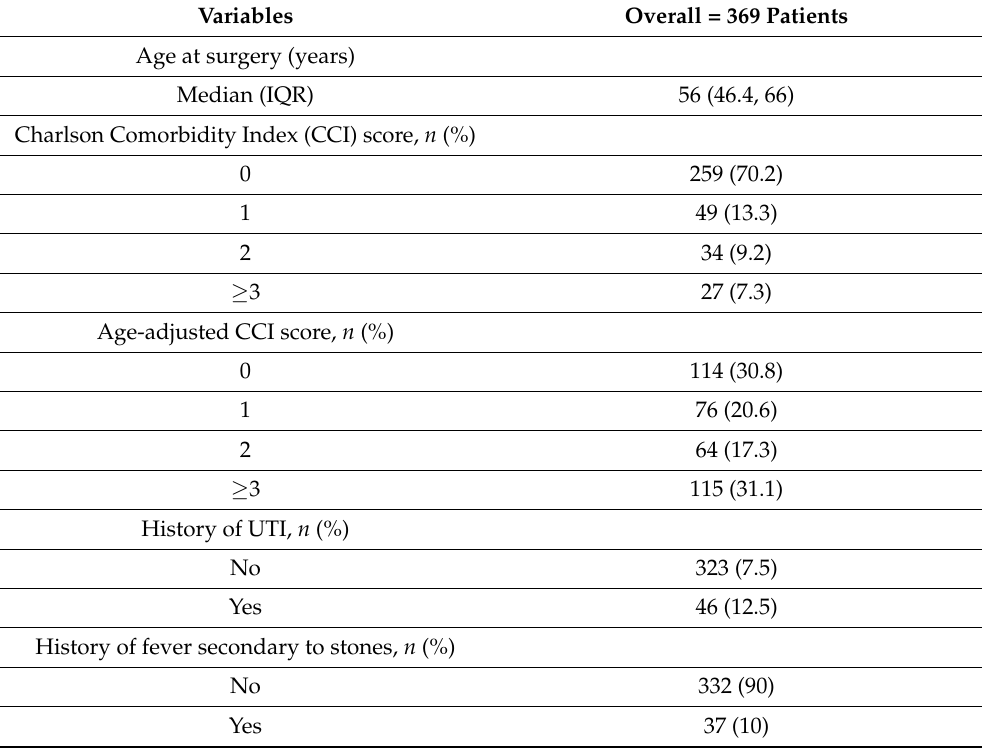
Table 1. Descriptive characteristics of the whole cohort of patients ( n = 369). All values are shown as median (interquartile range) or frequency